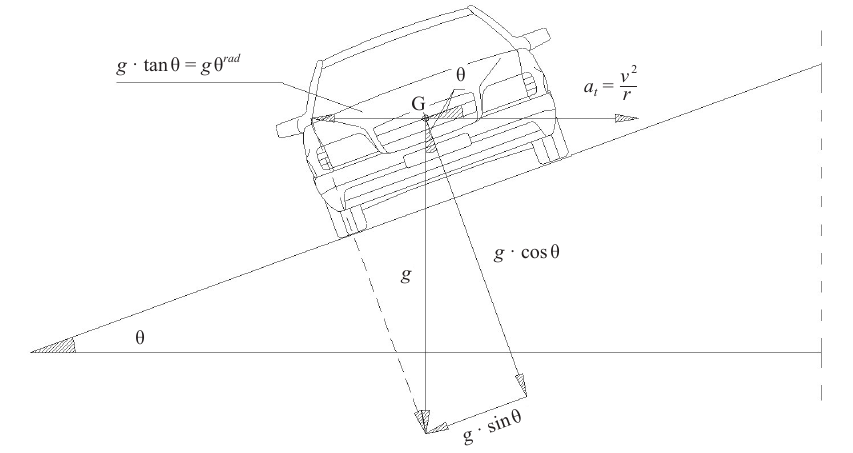
Figure 4. Cross-section of the roadway and pseudo-dynamic balance of the in-curve